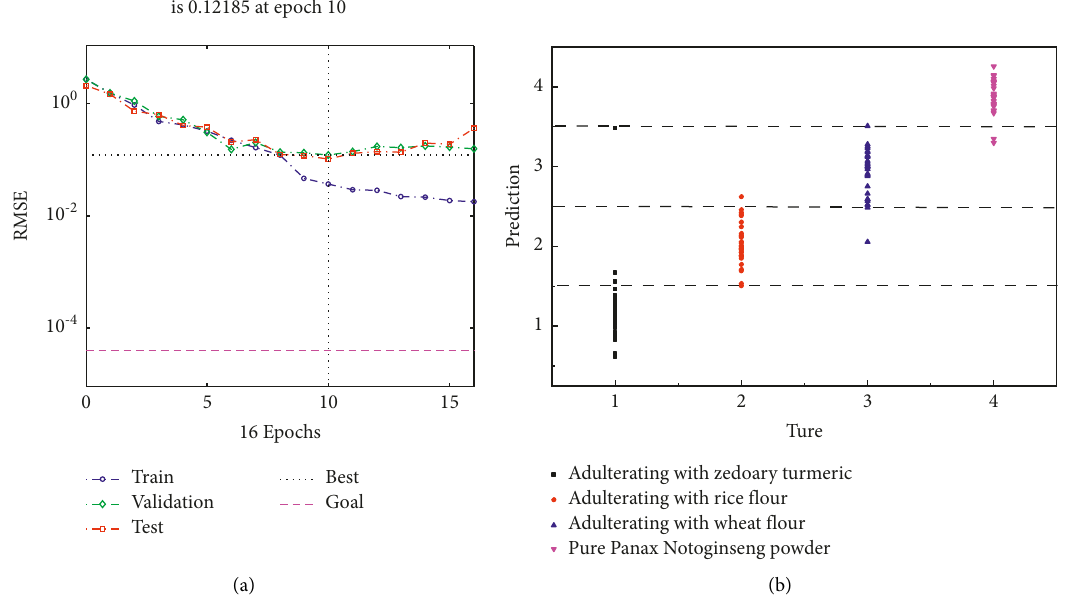
Figure 6: SPA-BPNN model results. (a) BPNN training process; (b) scatter diagram of BPNN prediction